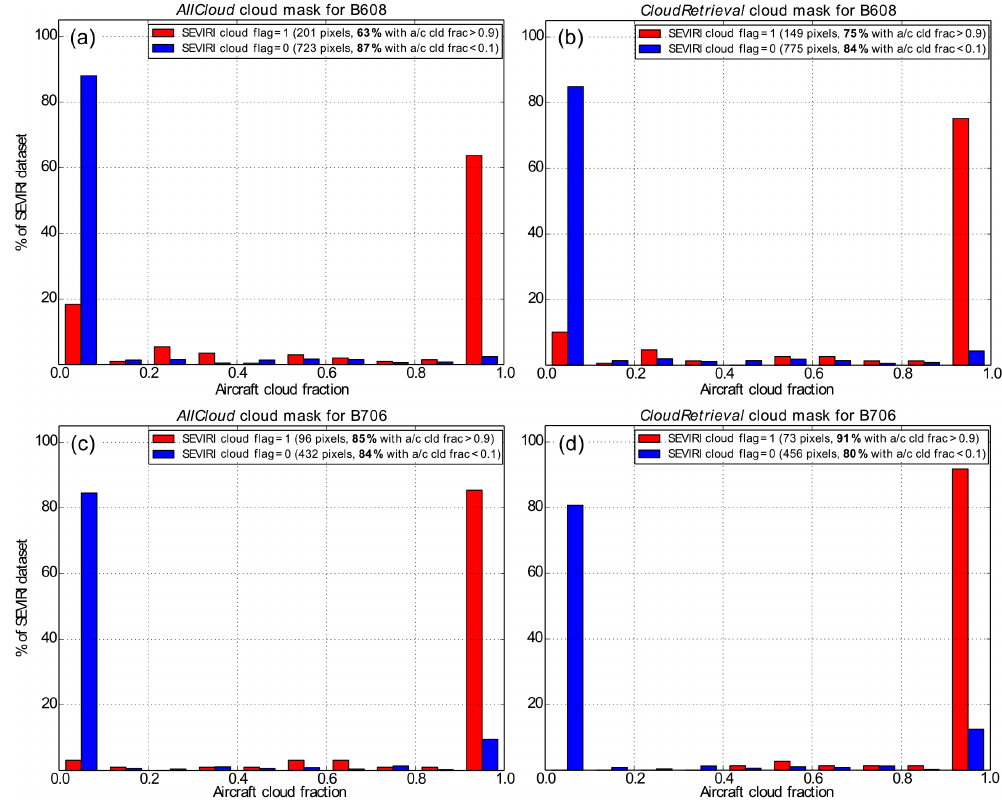
Figure 5. Histogram comparison of aircraft cloud fractions as matched to SEVIRI cloud flags showing pixels flagged as cloudy (red) and non-cloudy (blue) in SEVIRI. Percentage values in the legend pertain to aircraft cloud fractions greater than 0.9 for cloudy SEVIRI pixels, and less than 0.1 for non-cloudy SEVIRI pixels, to indicate the proportion of the dataset deemed to match. Flight B608 (a) AllCloud and (b) CloudRetrieval cloud masks. Flight B706 (c) AllCloud and (d) CloudRetrieval cloud